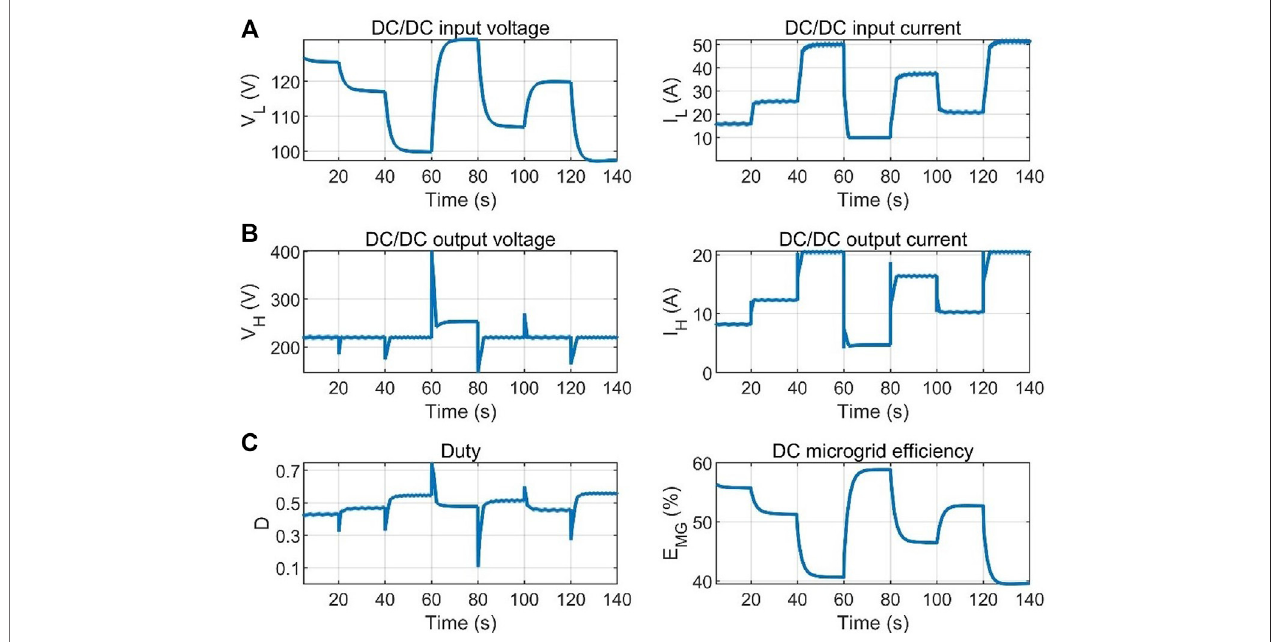
FIGURE 7 | Performances of the SOFC-based hybrid DC microgrid system. (A) DC/DC inputs; (B) DC/DC outputs; and (C) Duty and DC microgrid ef fi ciency.